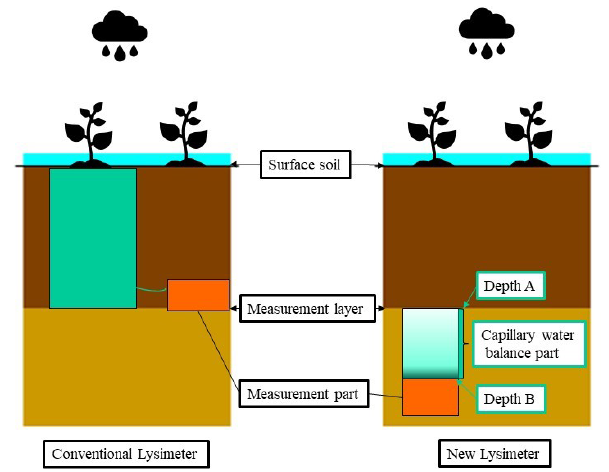
Figure 2. Schematic diagram of a conventional lysimeter and the newly designed lysimeter.